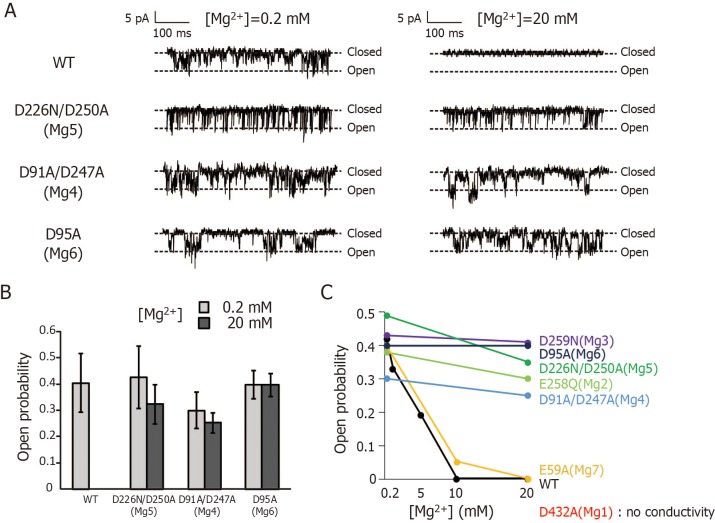
Patch-clamp analyses of wild-type and mutant forms of MgtE using the Mg2+-auxotrophic E. coli strain.(A) Membrane patches from E coli. giant spheroplasts expressing wild-type (WT) and Mg5- (D226N/D250A), Mg4- (D91A/D247A), or Mg6- (D95A) binding site mutants were clamped at voltage of −80 mV and single-channel currents were recorded in the presence of 0.2 mM or 20 mM Mg2+ on the periplasmic side. (B) Open probability of wild-type (WT) and Mg5-, Mg4-, or Mg6-binding site mutants in the presence of 0.2 mM or 20 mM Mg2+ on the periplasmic side was plotted. The data of wild-type in the presence of 20 mM Mg2+ were not plotted because no current upon channel-opening was observed. Experiments were repeated 3–4 times. (C) Plot of Mg2+-concentration dependence of the open probability of wild-type and Mg2+-binding site mutants of MgtE. Wild-type (WT) and Mg2-, Mg3-, Mg5-, or Mg7-binding site mutants were analysed at −40 mV in the previous paper (Hattori et al., 2009). Mg4- and Mg6-binding site mutants were analysed at −80 mV in this study. It should be noted that open probability of MgtE exhibited no membrane potential dependency (Hattori et al., 2009).